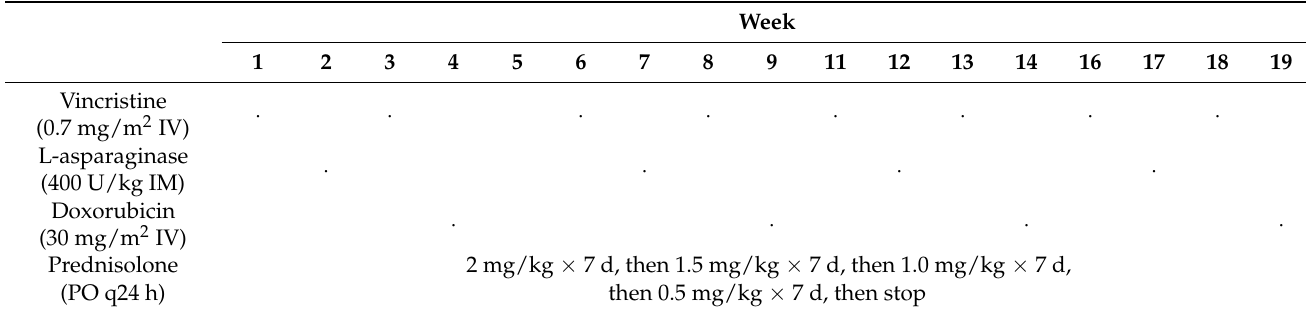
Table 1. LHOP chemotherapy